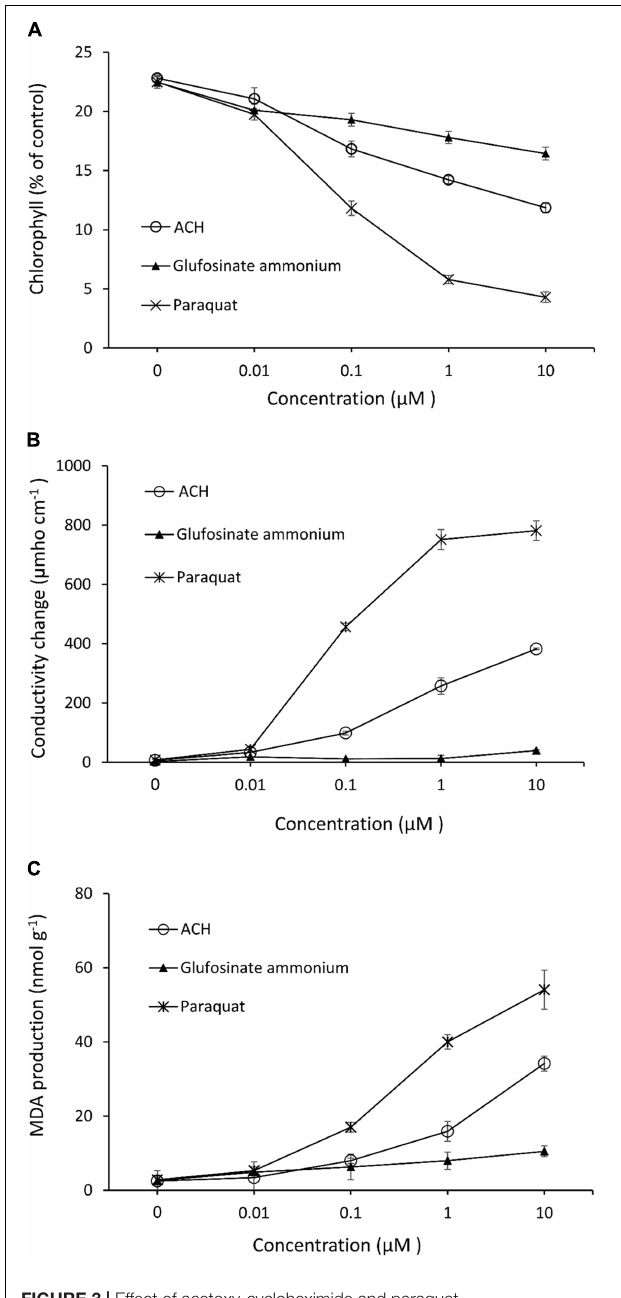
FIGURE 3 | Effect of acetoxy-cycloheximide and paraquat, glufosinate-ammonium on (A) chlorophyll contents (B) cellular leakage and, (C) MDA production of cucumber cotyledon leaf squares. The tissues were exposed to continuous light at 120 mmol/m 2 /s PAR at 25 ◦ C for 24 h, following 12 h of dark incubation. Error bars are ± 1 SE of the